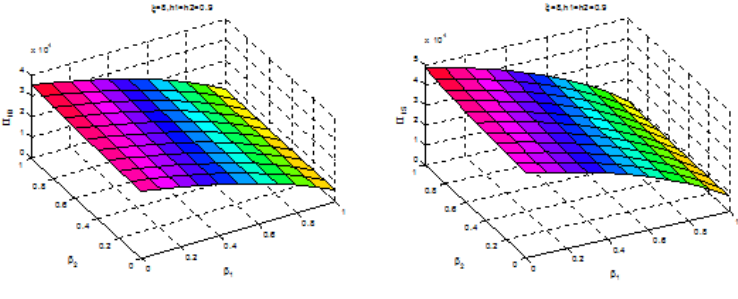
Figure 4. The change of the optimal profits with the return price in two games From Figure 4, we know that when c b   and the return rate is higher, the maximum profits of two supply chains can be achieved where the own supply chain takes no return policy and the competing supply chain takes the full refund policy.